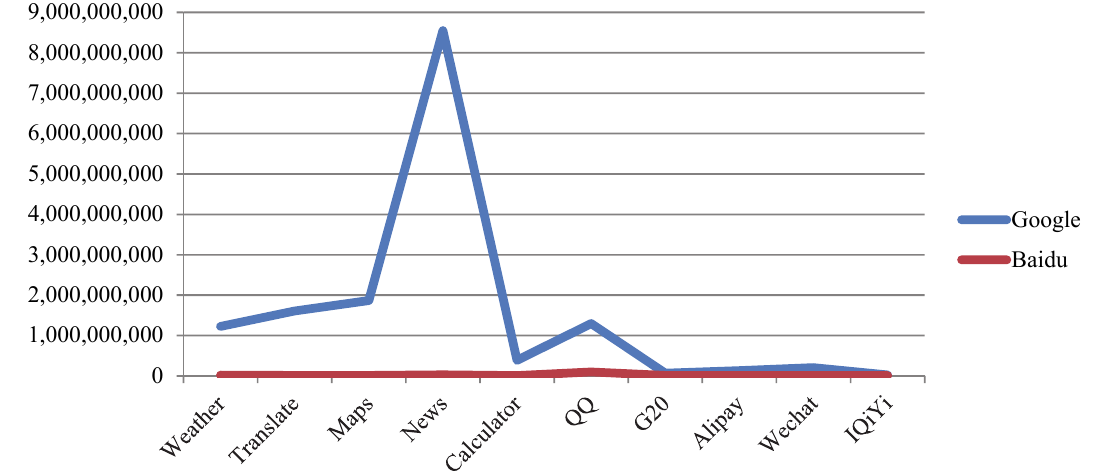
Fig. 4. Comparison of Number of webpages in each keyword search by Google and Baidu SEs (3)